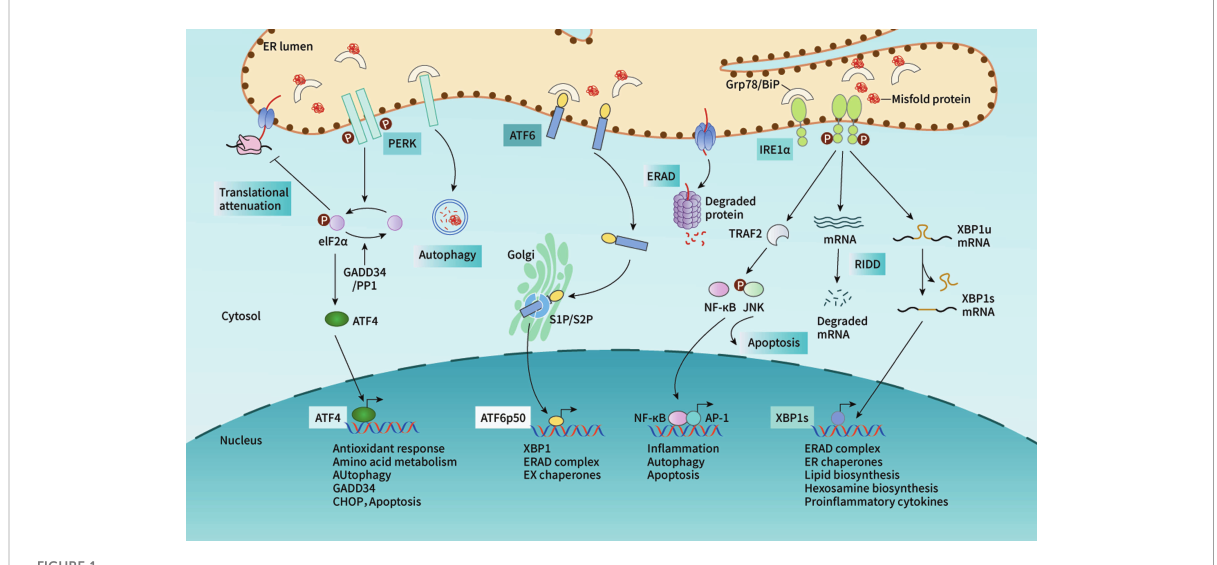
FIGURE 1 The UPR regulates the protein folding processes by activating three signaling pathways. Under stress, the release of GRP78 induces activation of PERK, which phosphorylates eIF2 a and then upregulates the expression of ATF4. As a transcriptional factor, ATF4 enters the nucleus and mediates the expression of downstream factors. Similarly, IRE1 a triggers the splicing activity to produce spliced XBP1, which is also a transcriptional factor in regulating the target gene expression. In addition, IRE1 a may also initiate cell apoptosis by activating TRAF2/JNK signaling. ATF6 is transported to Golgi, where it is cleaved and